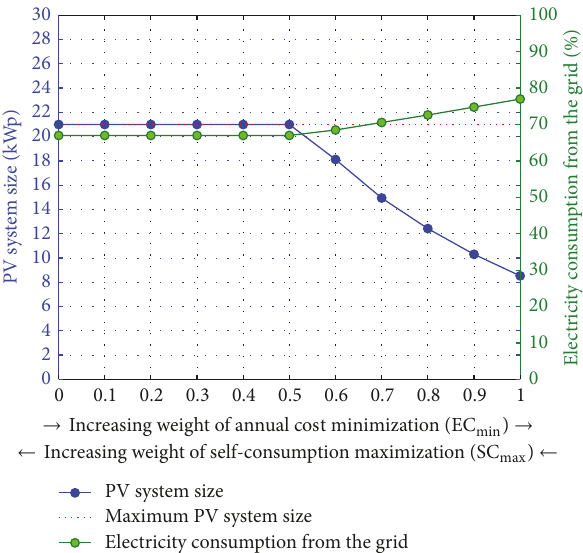
Figure 4: Austrian retail electricity prices: annual electricity costs for the individual apartments calculated for different weighting of objective functions.